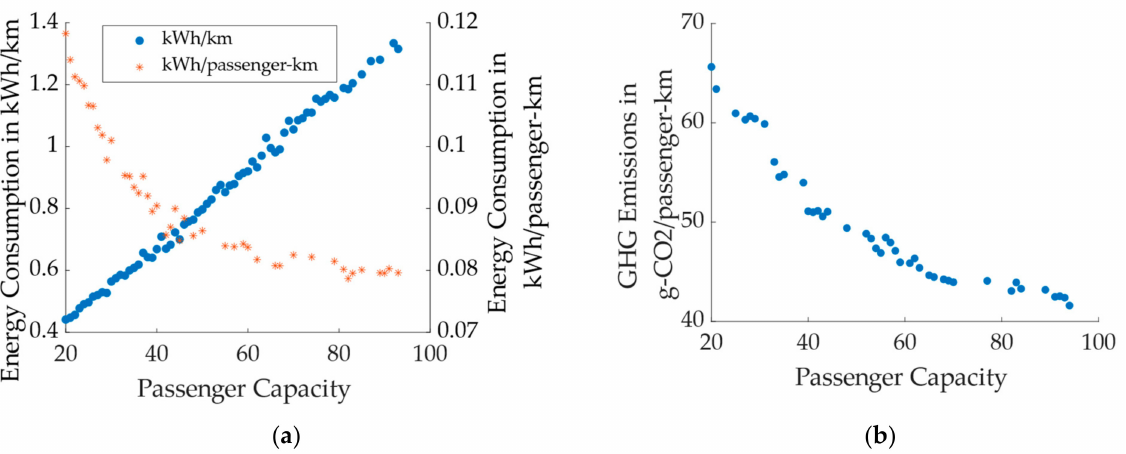
Figure 12. Influence of vehicle size on ( a ) energy consumption ( b ) GHG emissions. Similarly, due to the increase in energy consumption, the GHG emissions of smaller vehicles also increase from 41.5 to 65.6 g-CO 2 /passenger-km for vehicle sizes of 94 and 20 passengers, respectively, as shown in Figure 12b. Figure 13 shows the required motor power and battery capacity for different vehicle sizes. In Figure 13a, all feasible combinations of installed motor power simulated for different vehicle sizes are shown. The minimum motor power required to drive according to the analyzed driving cycle increases from 115 kW to 310 kW for a 20 and 94 passenger vehicle, respectively. Concepts with installed power below the curve did not meet the torque and speed requirements.